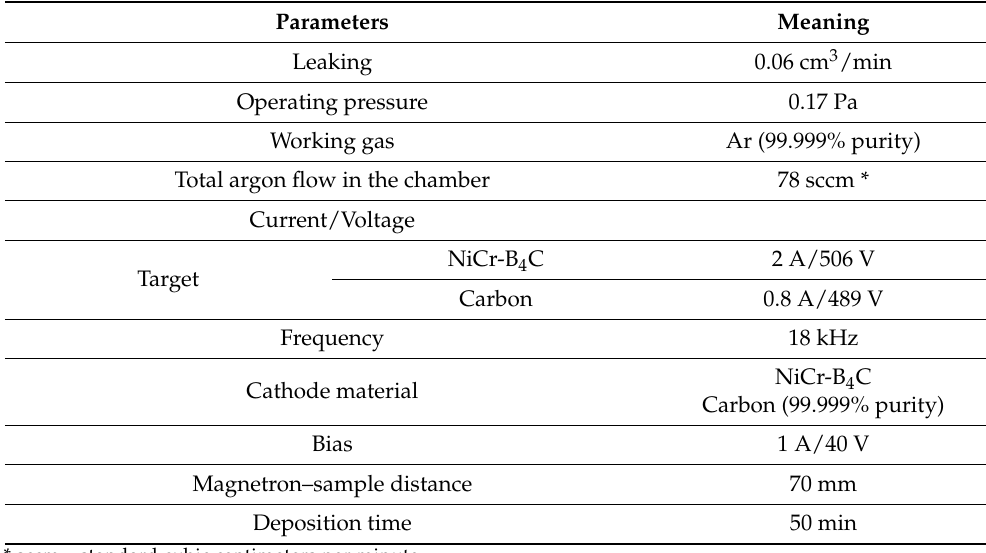
Table 2. Parameters of deposition of the NiB-Cr 7 C 3 coating on a 65G steel substrate using UNICOAT